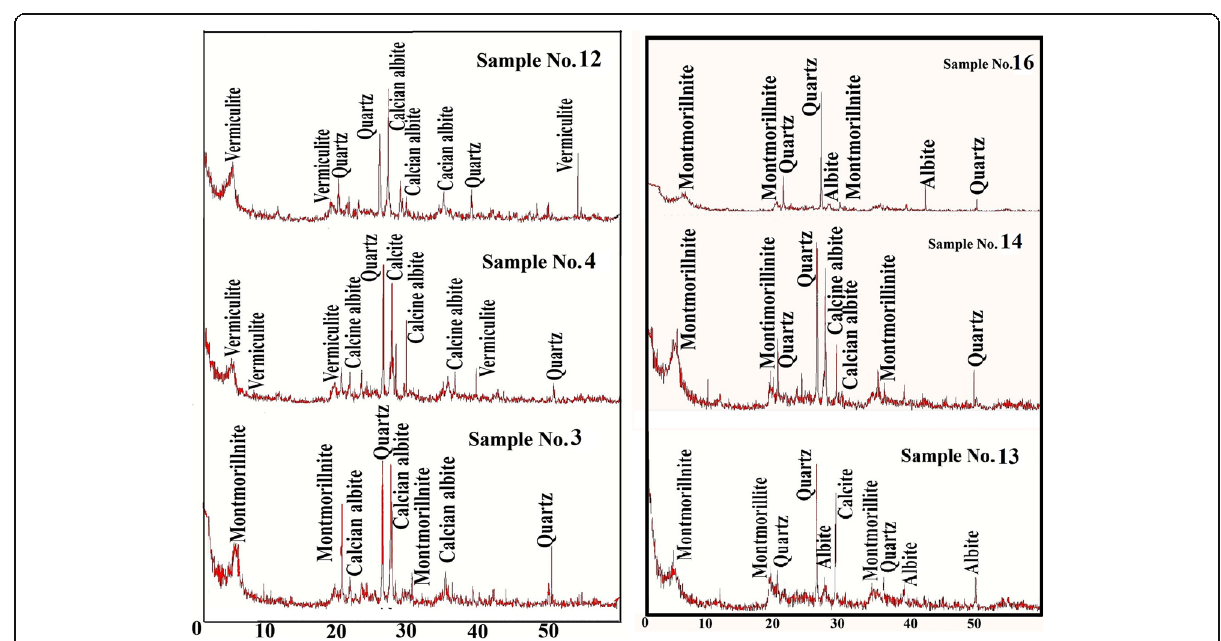
Fig. 3 X-ray diffraction results of Assiut soil samples